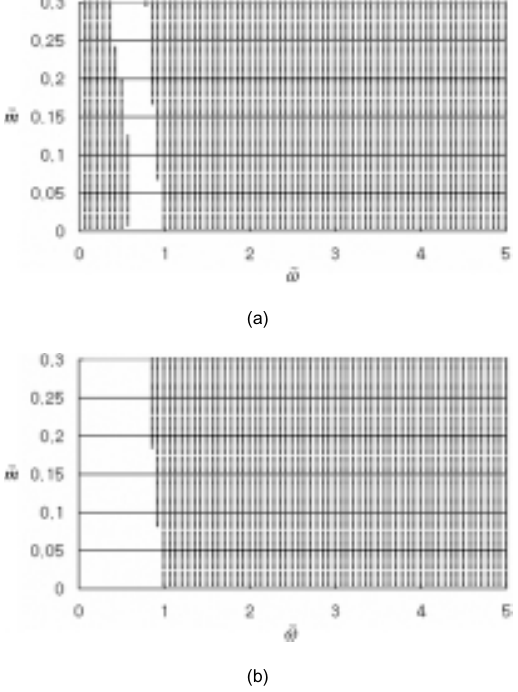
Fig. 7. Comparison of stability for the variation of ˜ ω and ˜ m . (a) Pendulum Automatic Dynamic Balancer. (b) Ball Automatic Dynamic